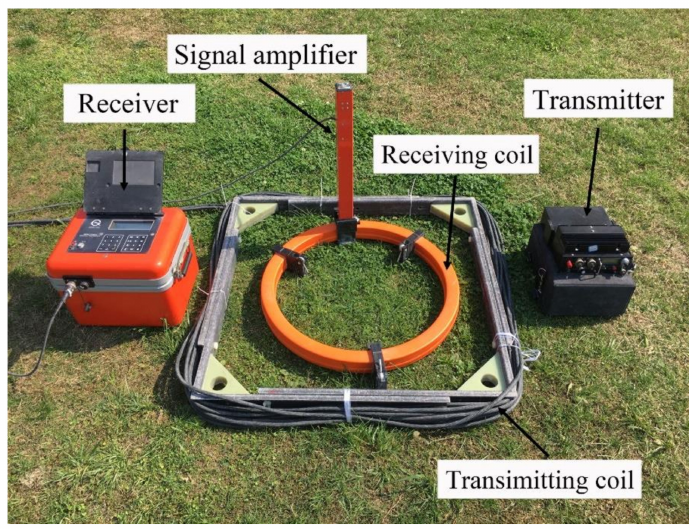
Figure 9. The PROTEM47 transient electromagnetic instrument.